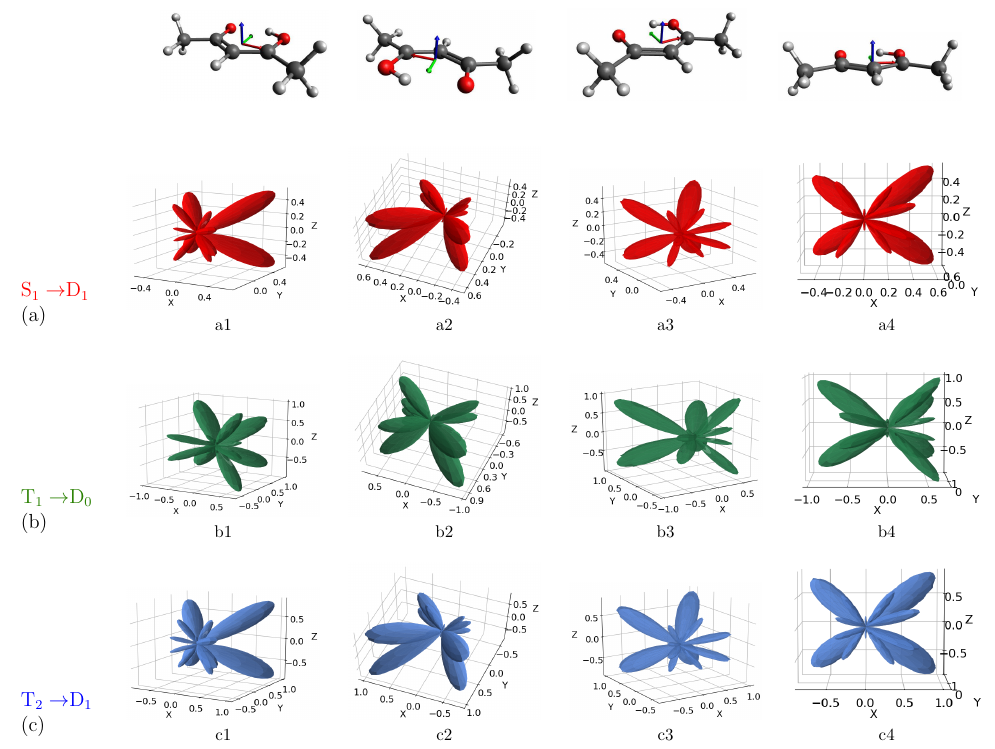
Figure 3. Computed MFPADs for the photoionization from the S 1 ( a ), T 1 ( b ), and T 2 ( c ) excited states of acetylacetone to the corresponding first ionic state, at the selected kinetic energy of 6.04 eV. The electric field is oriented along the x axis. Orientation of the molecule is also shown on top of figure (x, y, z axes are, respectively, identified by red, green and blue